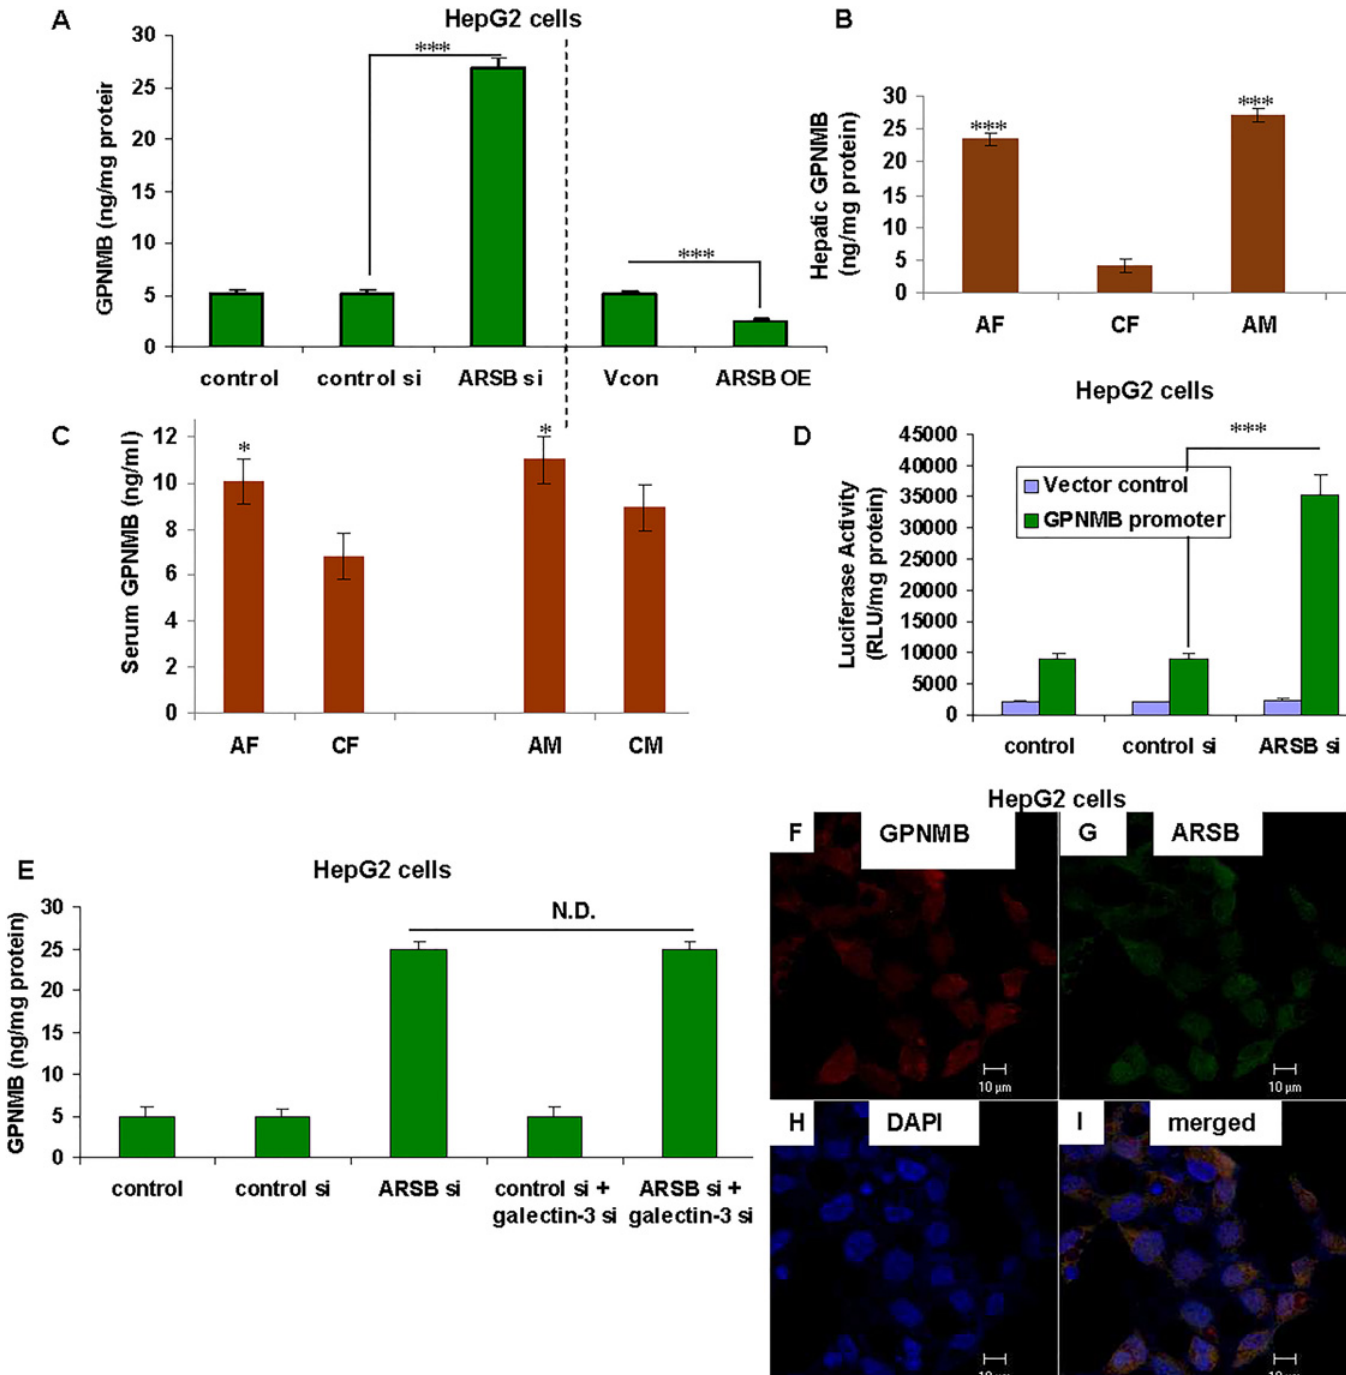
Fig 1. Increase in GPNMB following ARSB decline in hepatic cells and in ARSB-deficient mice is not mediated by galectin-3. (A) GPNMB protein was measured by ELISA in the HepG2 cells following ARSB knockdown. The level increased from 5.1 ± 0.4 ng/mg protein to 26.8 ± 1.1 ng/mg protein when ARSB was silenced by siRNA (p < 0.001; one-way ANOVA with Tukey-Kramer post-test; n = 6)). Following ARSB overexpression, GPNMB declined to 2.4 ± 0.2 ng/mg protein (p < 0.001, n = 6). (B) In hepatic tissue from ARSB-null mice, gpnmb mRNA expression increased to more than 5.5 times the baseline in both female and male mice, compared to controls (p < 0.001; n = 5 per group). (C) GPNMB also increased in the serum of the ARSB-null female and male mice, compared to normal, gender-matched controls (p < 0.05, unpaired t-test, two-tailed; n = 5 per group). (D) GPNMB promoter activity was detected by luciferase assay, and increased to ~3.5 times the baseline level when ARSB was silenced (p < 0.001, n = 6). (E) In the HepG2 cells, galectin-3 silencing did not inhibit the increase in GPNMB that followed ARSB silencing (n = 3). (F,G,H,I) In the HepG2 cells, confocal images show prominent GPNMB staining ( F , red) and ARSB staining ( G , green) diffusely throughout the cytoplasm. Co-localization is apparent in the merged image ( I, yellow). Nuclei are stained blue by